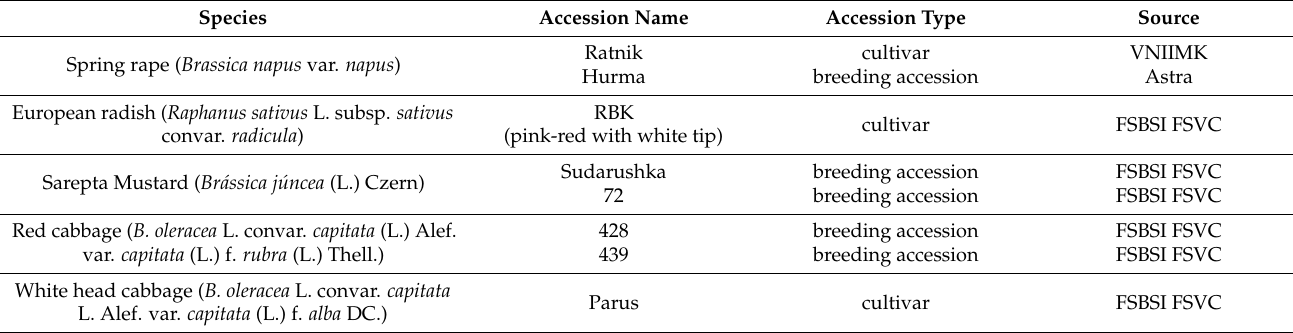
Table 1. Accessions of the Brassicaceae family used in the